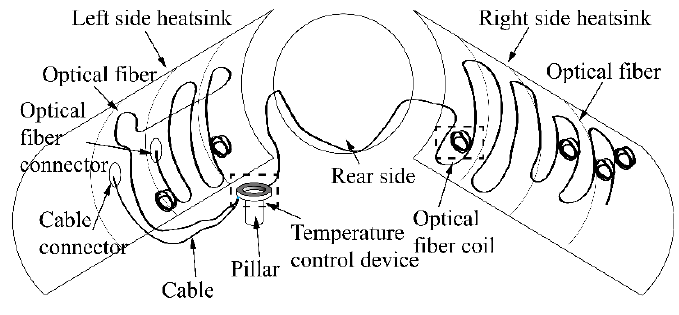
Figure 4. Diagram of the inside of the heatsink.